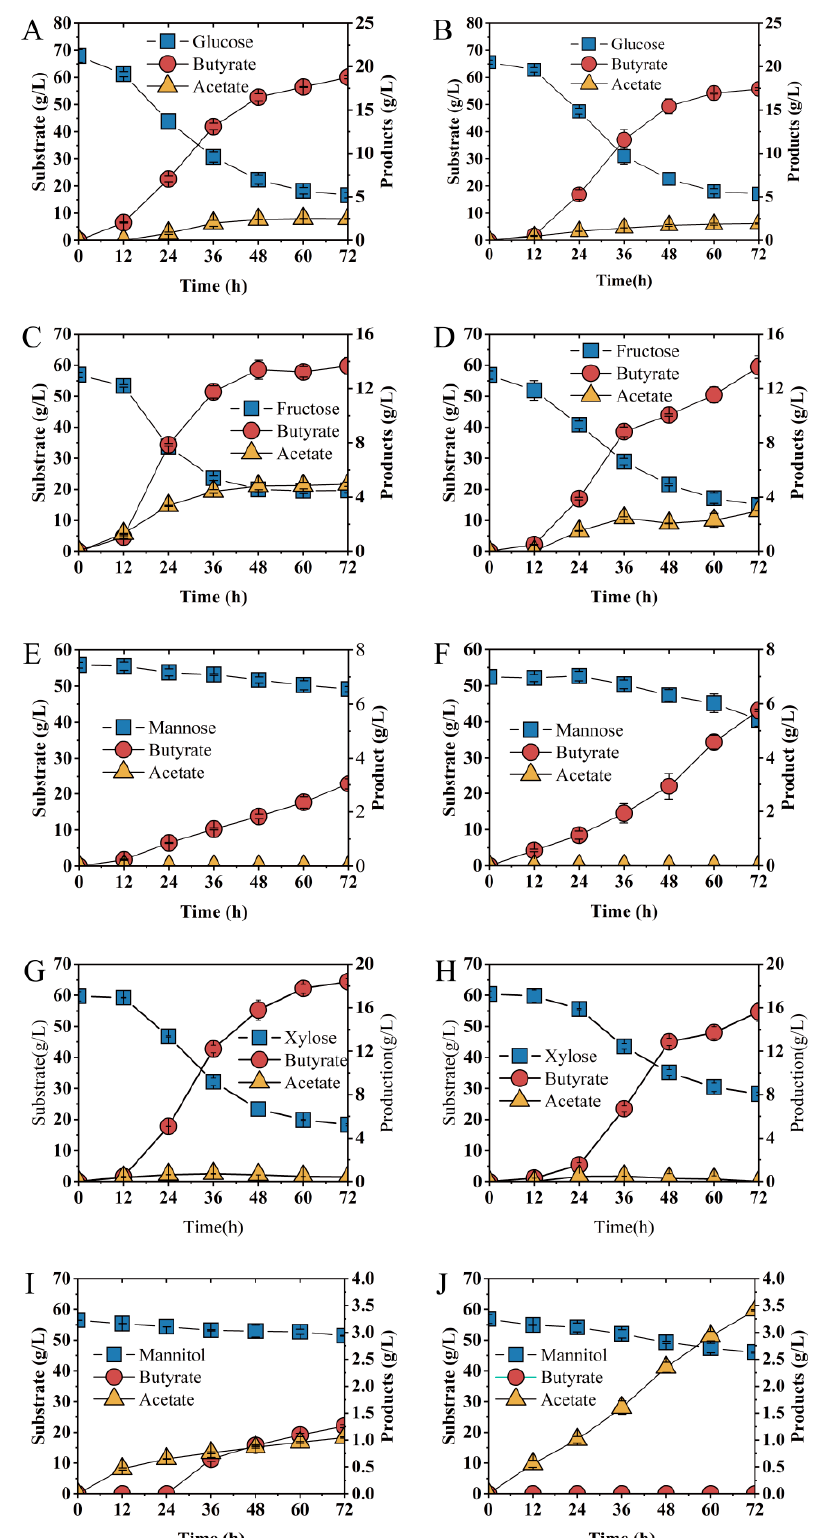
Figure 6. Fermentation kinetics of Ct ( left row) and Ct/ ∆ abrB ( right row) under different substrates as sole carbon source in CGM supplement with CaCO 3 . Glucose ( A , B ), Fructose ( C , D ), Mannose ( E , F ), Xylose ( G , H ) and Mannitol ( I , J ) in CGM supplement with CaCO 3